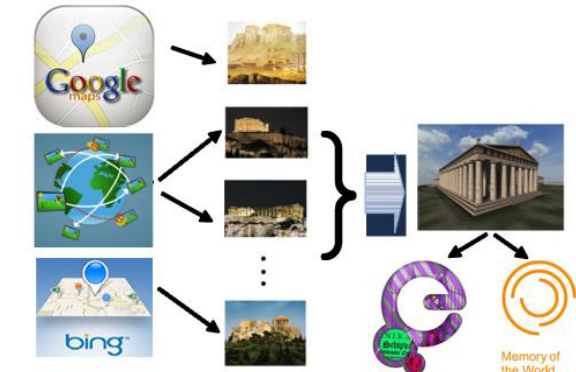
Figure 1: The search engine approach adopted in this